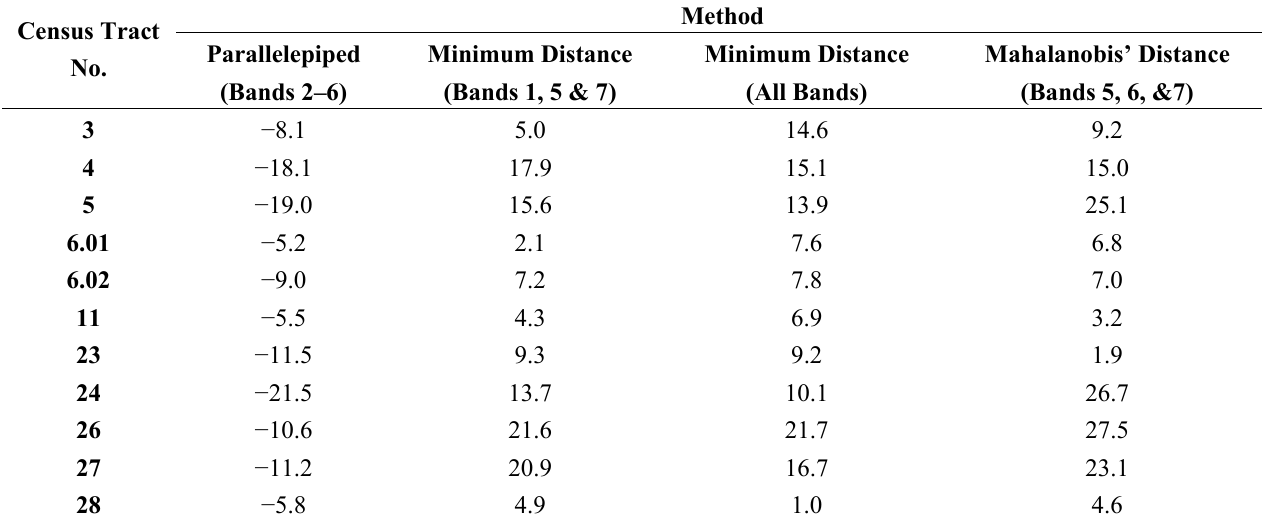
Table 6. Difference in percent imperious between aerial photo delineation and classified images, listed by census tract